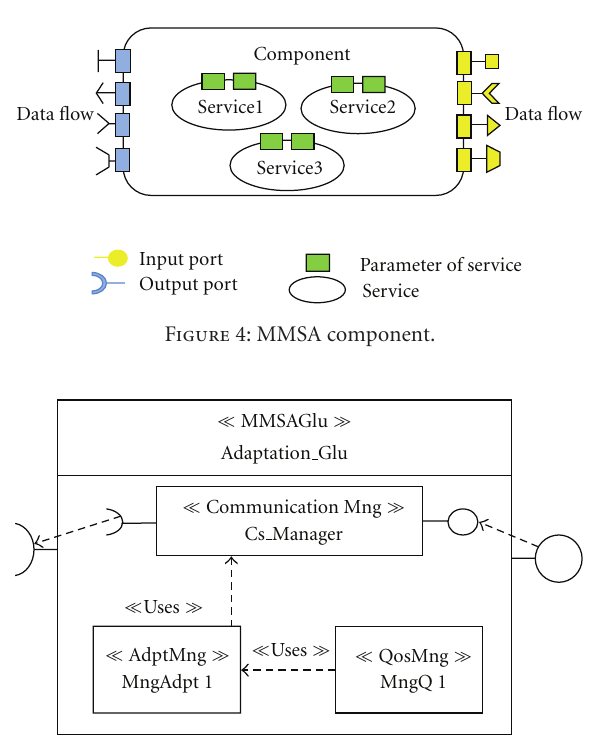
Figure 5: Internal structure